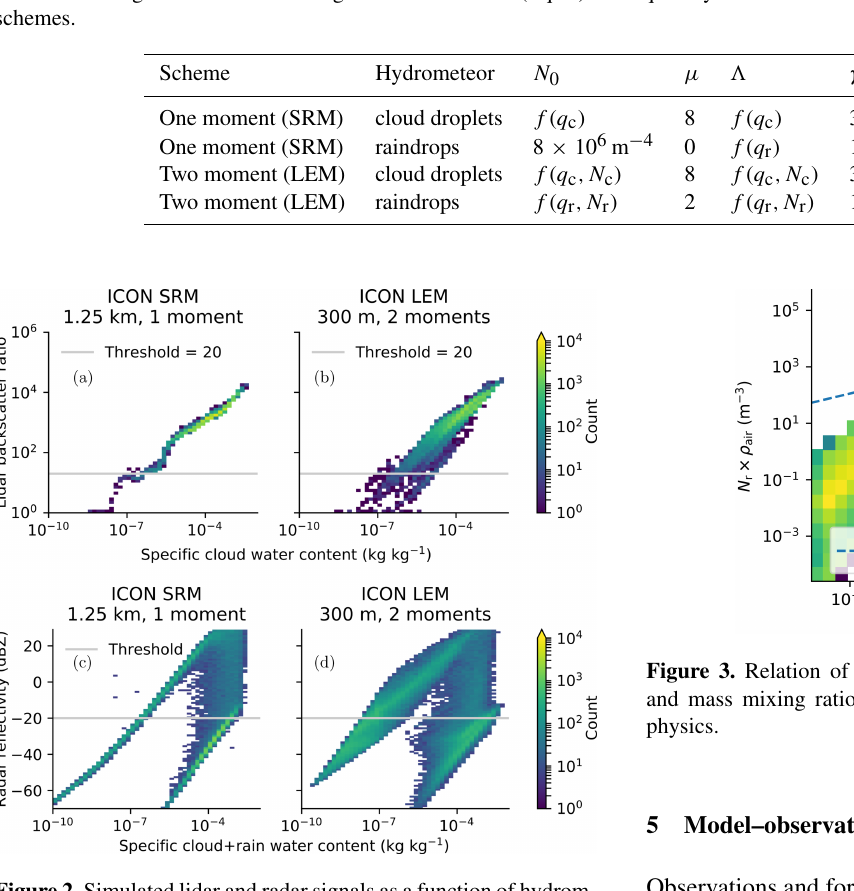
Figure 2. Simulated lidar and radar signals as a function of hydrom- eteor contents. CR-SIM and PAMTRA simulate the observable lidar and radar signals from drop size distributions in the one-moment ICON SRM and two-moment ICON LEM microphysical models. Signals are simulated without attenuation as they would be sensed at cloud top.